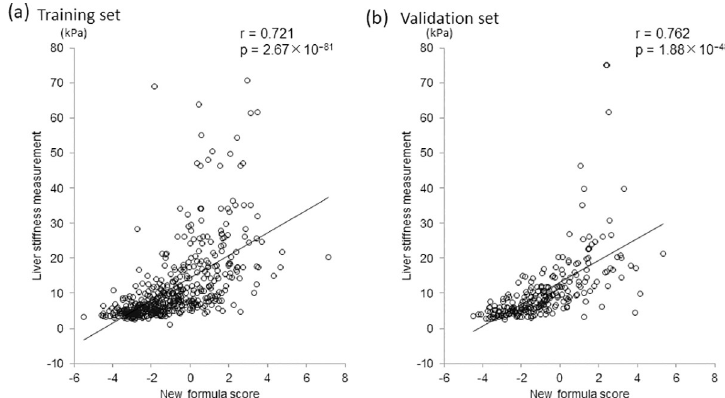
Fig 3. Correlation between novel formula scores and liver stiffness measurement values in the training (a) and validation sets (b). Significant, positive, and strong correlations were found between the scores and values.